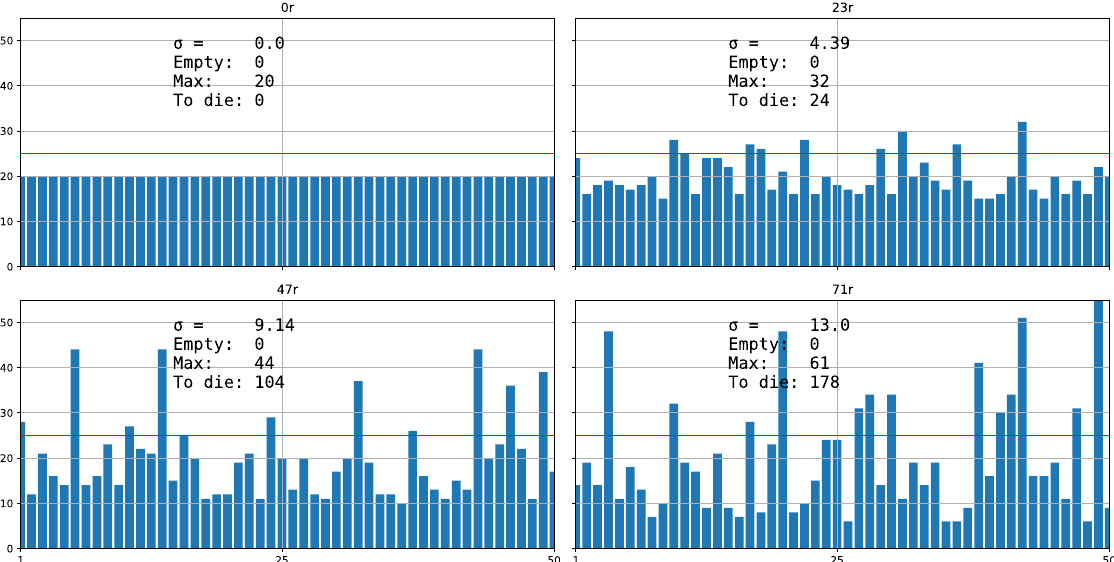
Figure 3. Strategy r. In this case, each chart is not a successive generation as shown in Figure 1. Each chart represents a different distribution strategy, which successively increases the prefix assigned to Distribution in the initial configuration by 23 percentage points (from 0r to 73r ). The higher the assigned prefix, the more aggregated the distribution. The greater the variance ( σ in the figure), the higher the density of the most populated cell ( Max in the figure) and the greater the number of excluded organisms ( To die in the figure) because they exceed the carrying capacity ( k = 25, line red in figure). There are no empty cells ( Empty = 0 in the figure). The h strategy is a variant of the r strategy in which the user chooses the proportion of the dispersion reticulum reduction, with the rest of the cells being empty (Figure 4).